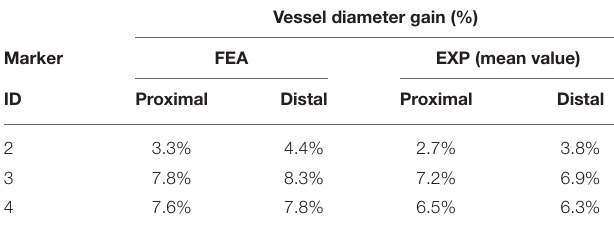
TABLE 2 | Comparison between the diameter gain obtained in the numerical simulations and experiments involving the idealized vessel design.